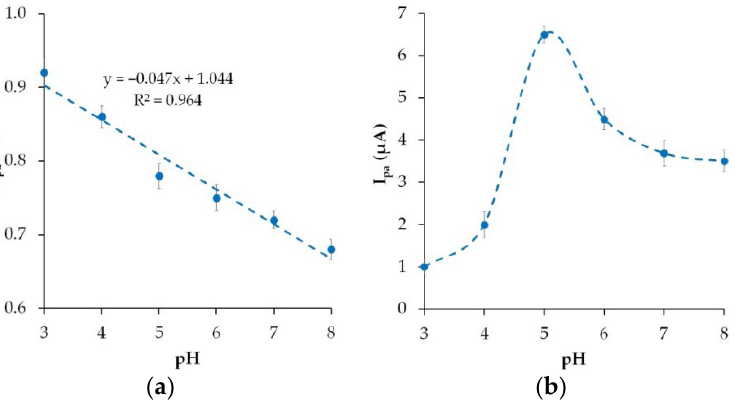
Figure 8. The effects of pH on the anodic peak potentials ( a ) and anodic peak currents ( b ) of 10 μM Ponceau 4R on phyto-AuNPs/PDDA-G/CP electrode.